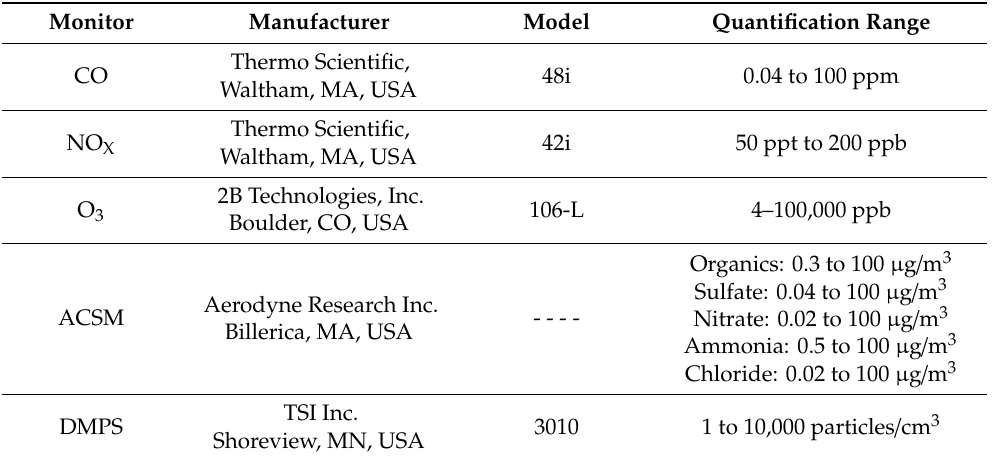
Table 2. Monitors used; models, manufacturers, quantification ranges. ACSM: aerosol chemical speciation monitor; DMPS: di ff erential mobility particle